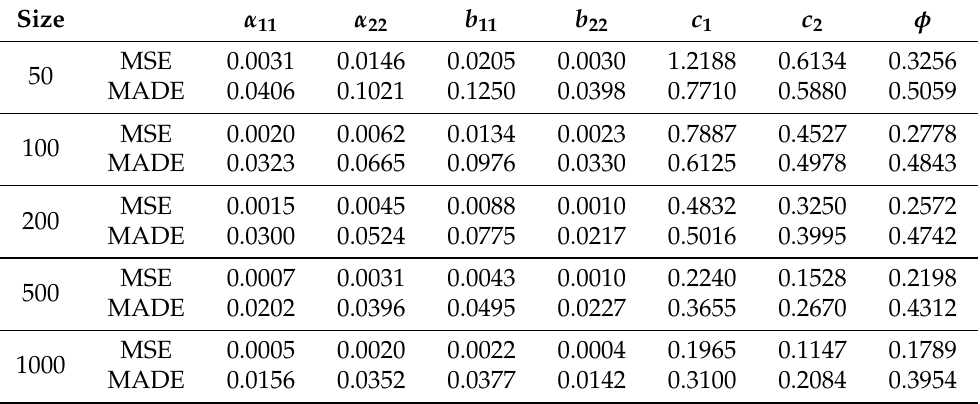
Table 2. Results for diagonal EBINAR(1) model with parameter I.